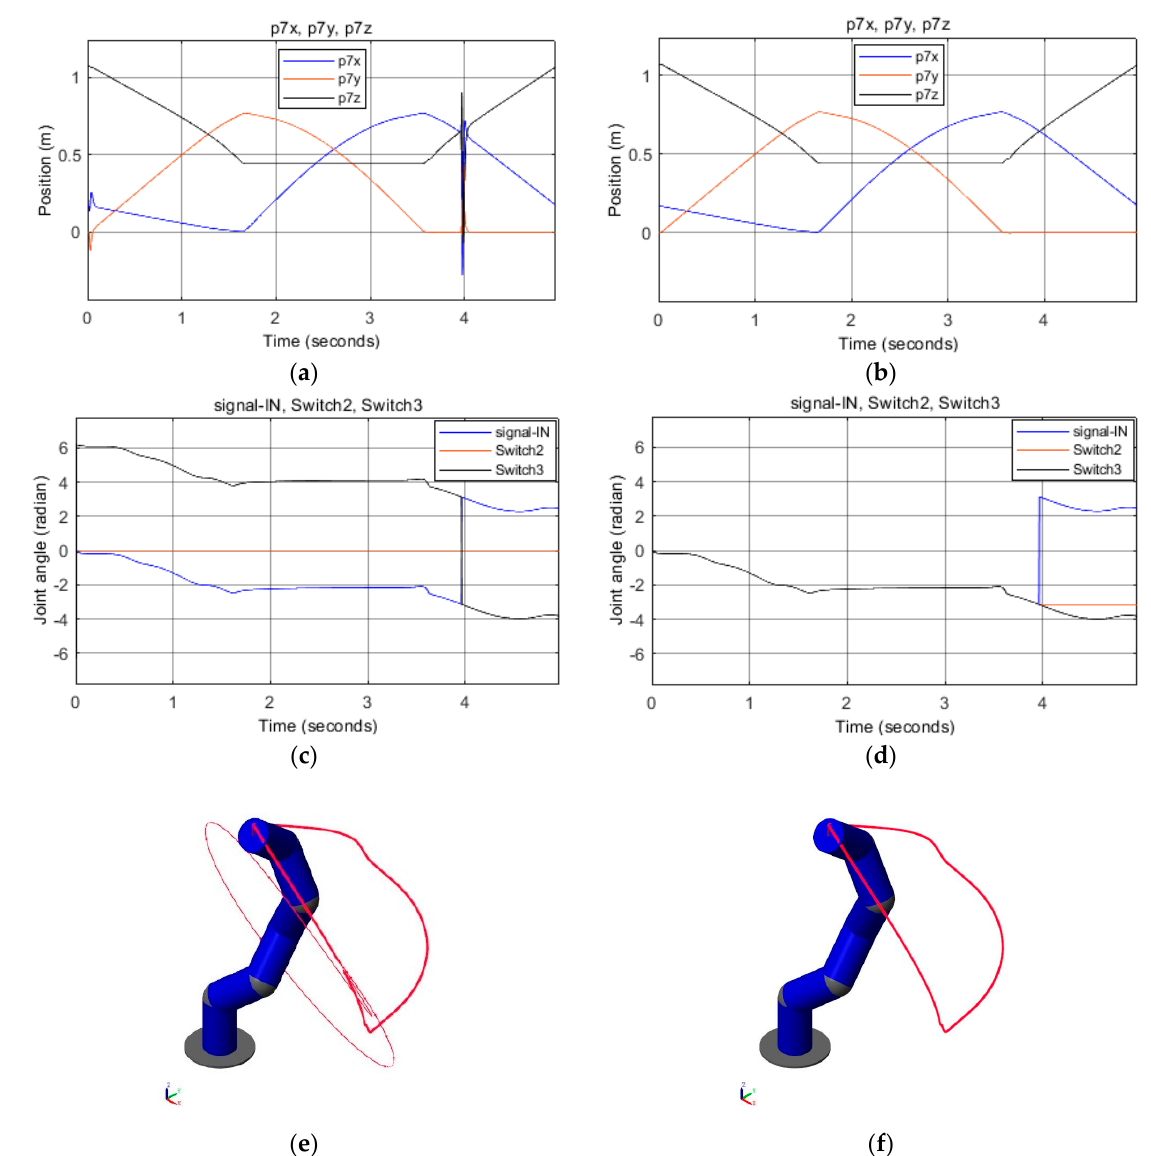
Figure 5. With time derivations of the position, the characteristics of instantaneous velocity and accelerations are deformed even more.